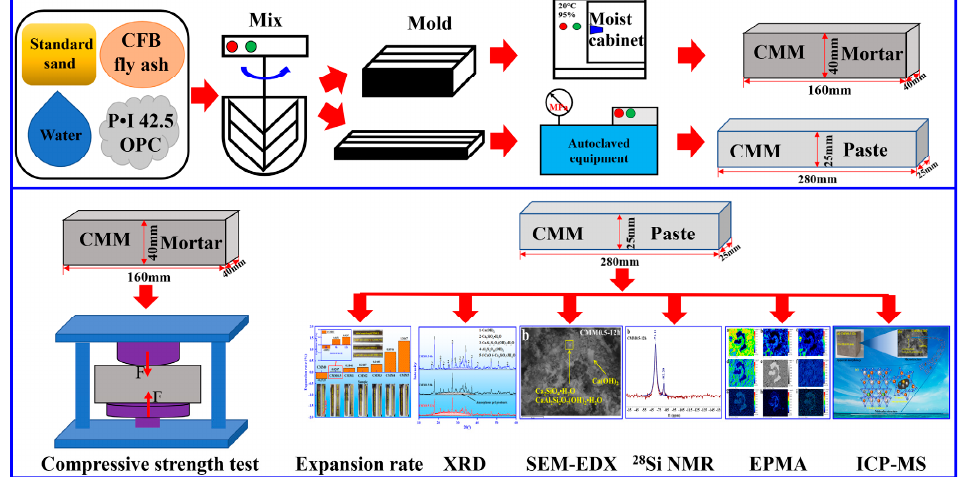
Figure 4. Schematic diagram of CMM preparation process and detection